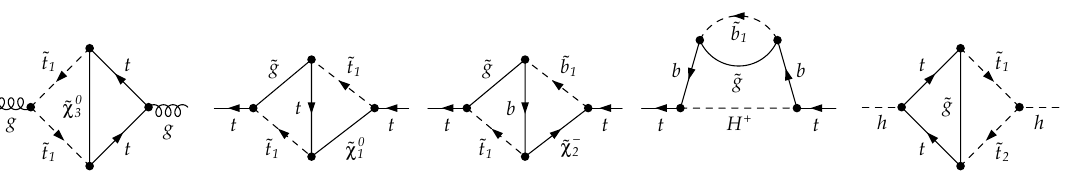
and (cid:16) h with gluons ( g ), top quarks ( t ), t